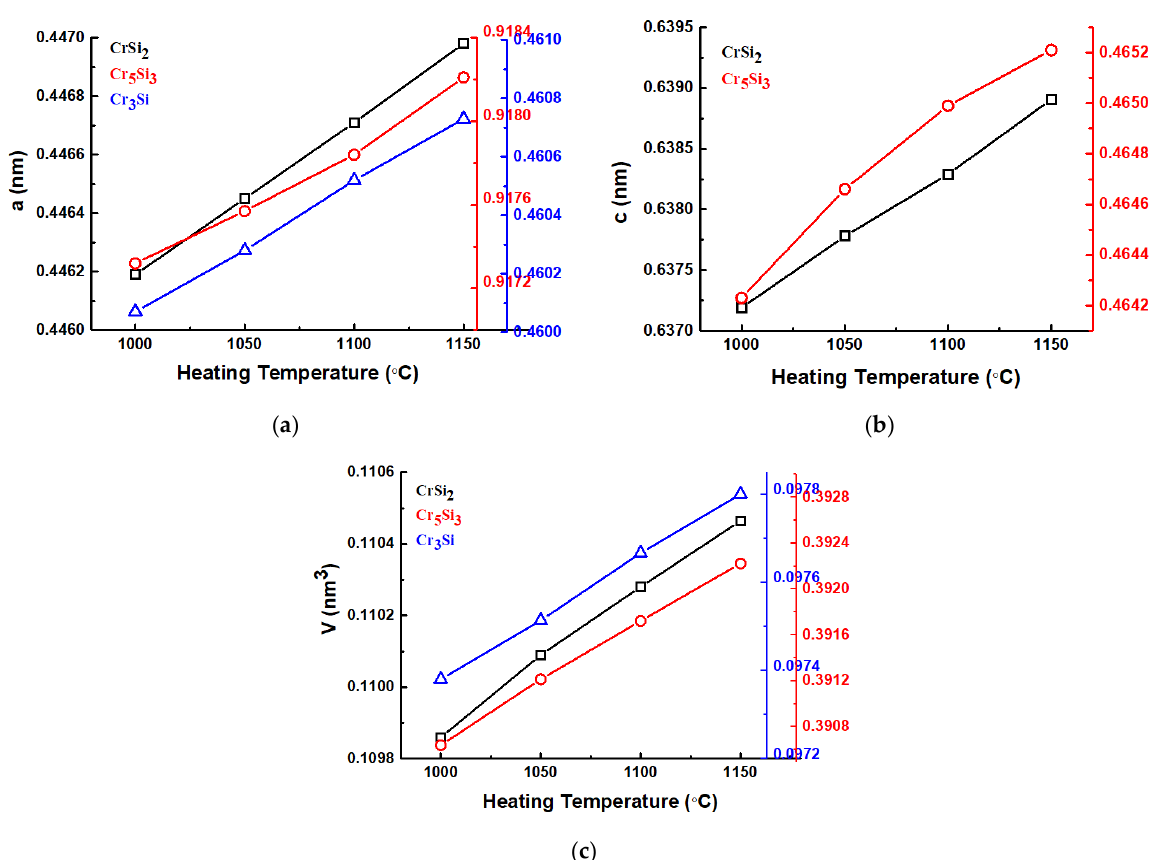
Figure 5. ( a , b ) Refined lattice parameters; ( c ) cell volume of CrSi 2 , Cr 3 Si, and Cr 5 Si 3 as a function of temperature.